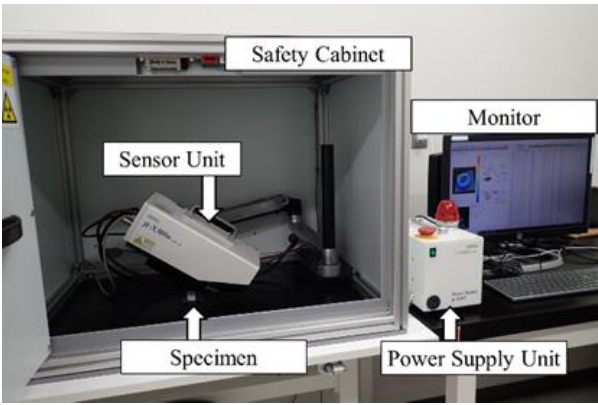
Figure 4. Photograph of residual stress measurement.